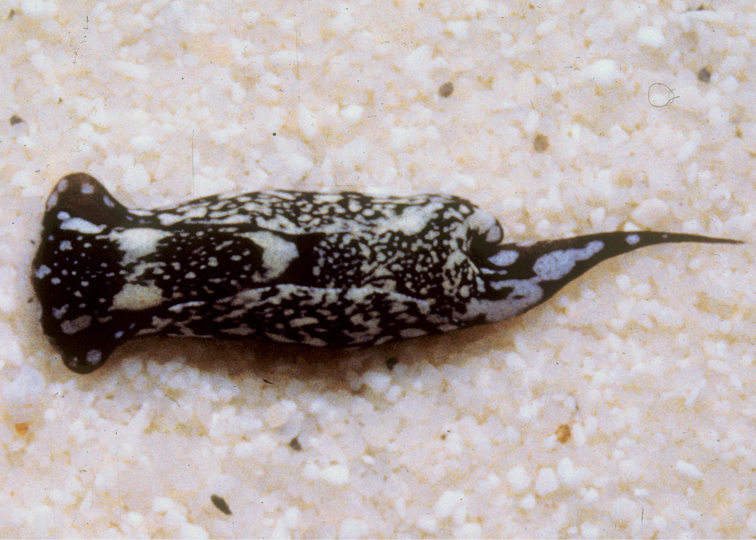
Chelidonura sandrana, Maldives, photo: J Hinterkircher (no spcm).